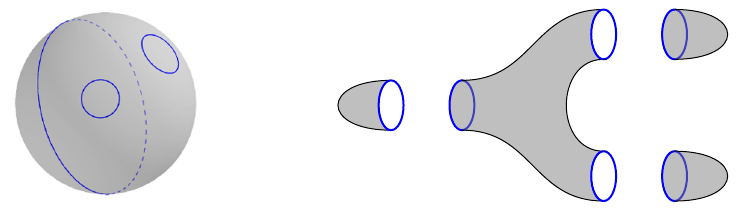
Figure 3 . A sphere with three Wilson loops is cut into three disks plus a remaining pair of